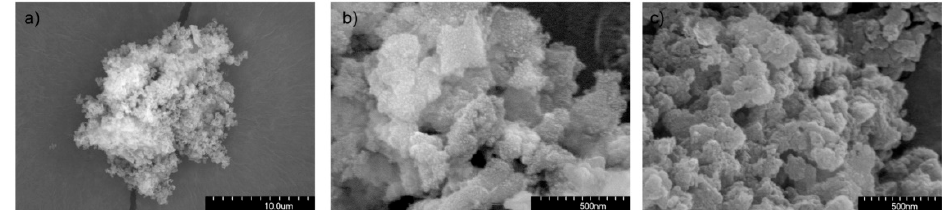
Figure 2. Scanning electron microscope images of ( a , b ) mesoporous material (low and high resolution, respectively) and ( c ) the functionalized material containing 3% GLYMO.